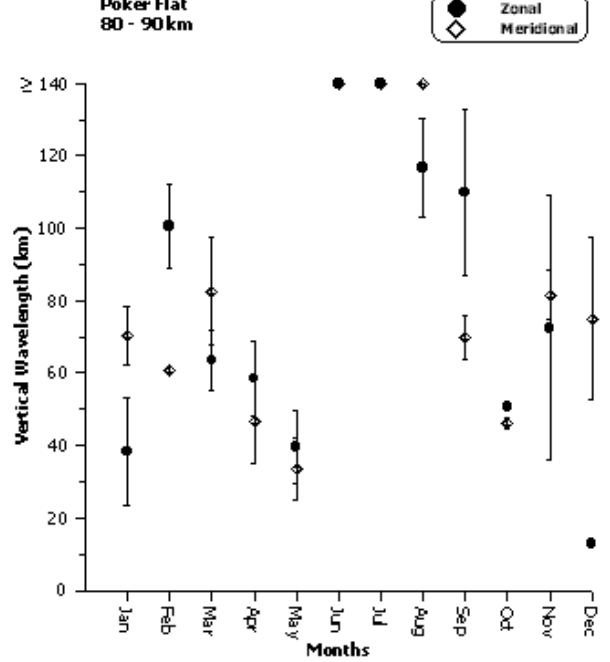
Fig. 9. Two-year averaged vertical wavelengths of the semidiurnal tide at Poker Flat. Vertical wavelengths ≥ 140km are shown by symbols along 140km